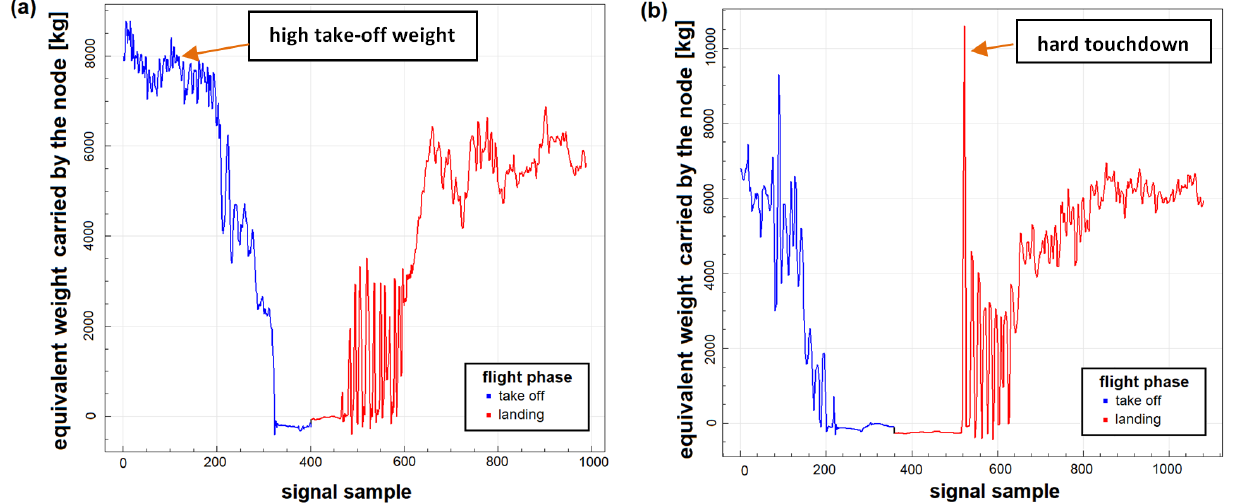
Figure 15. An example of system records for flights with high values of Landing Fatigue Equivalent obtained for full stop landing: ( a ) flight with increased take-off aircraft weight; ( b ) flight with hard touchdown.